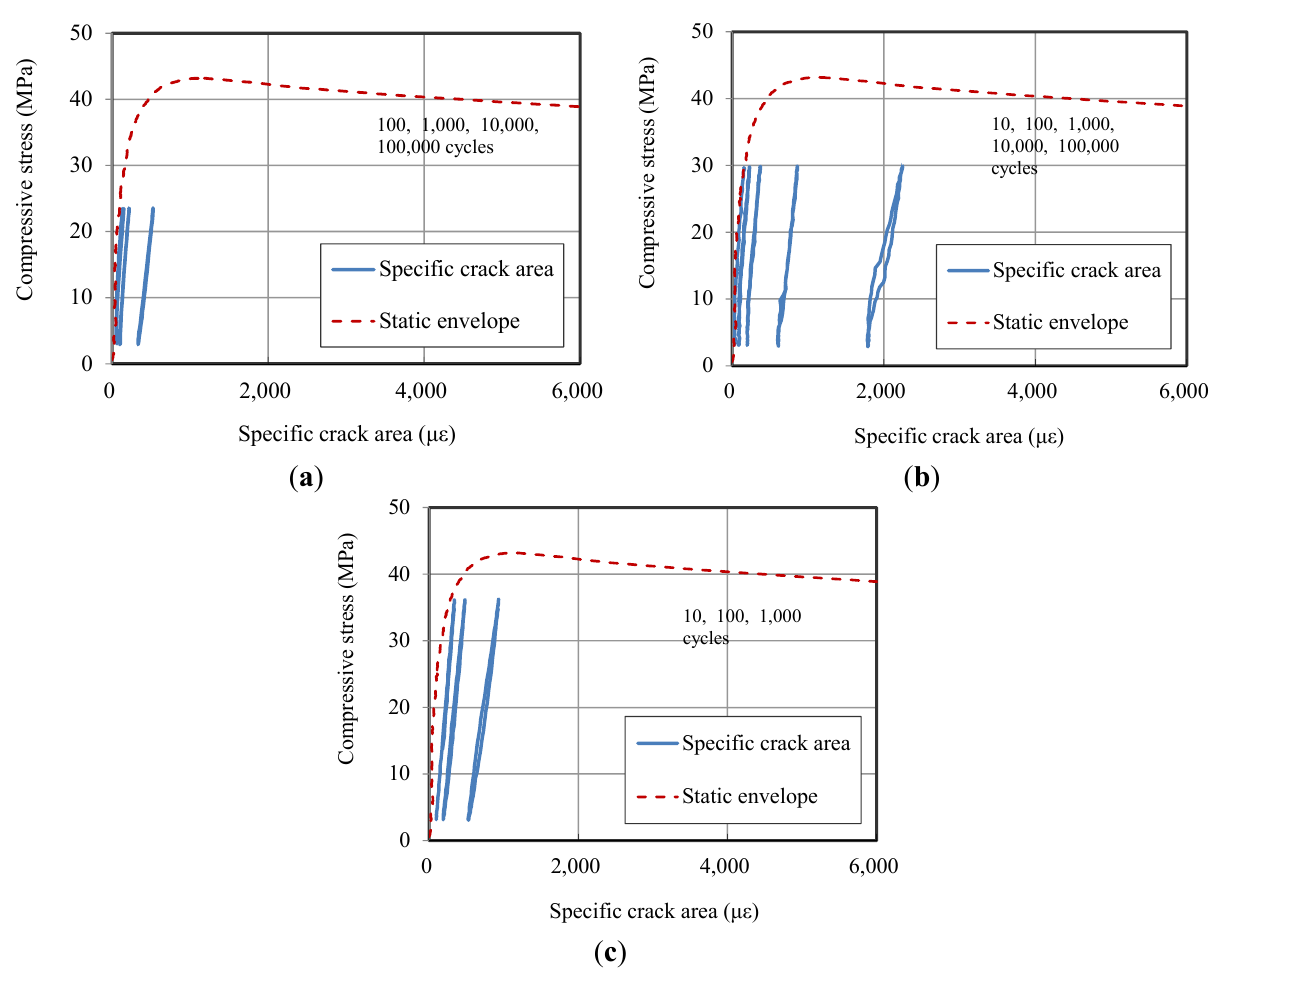
Figure 9. The evolution of damage to HPFRCC in repeated loading conditions: ( a ) the maximum stress is 55% of the static strength; ( b ) the maximum stress is 70% of the static strength; and ( c ) the maximum stress is 85% of the static